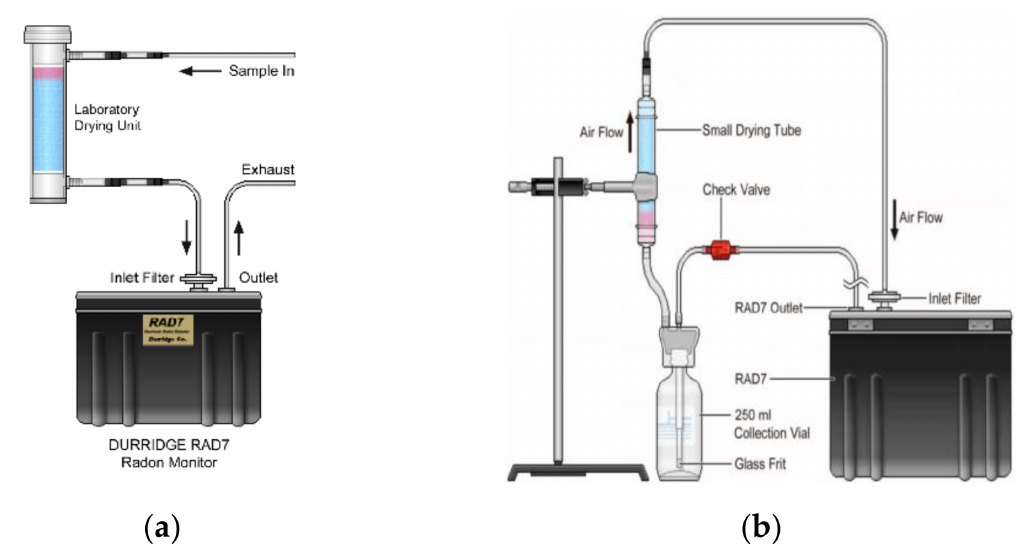
Figure 2. ( a ) Experimental setup for the “purging” phase and ( b ) experimental setup for radon-in-water measurements (modified from